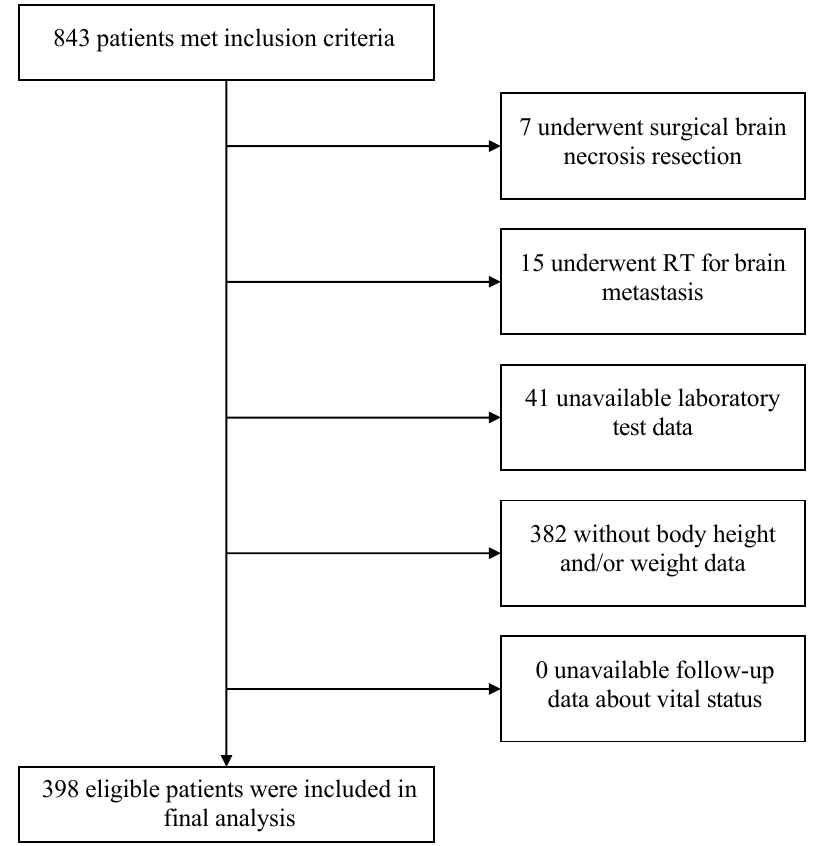
Figure 1. Study flowchart. Abbreviation: RT, radiotherapy.